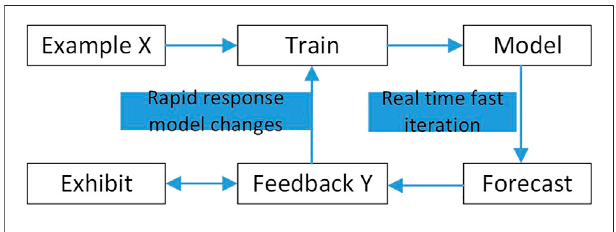
FIGURE 1 | Flow chart of online learning